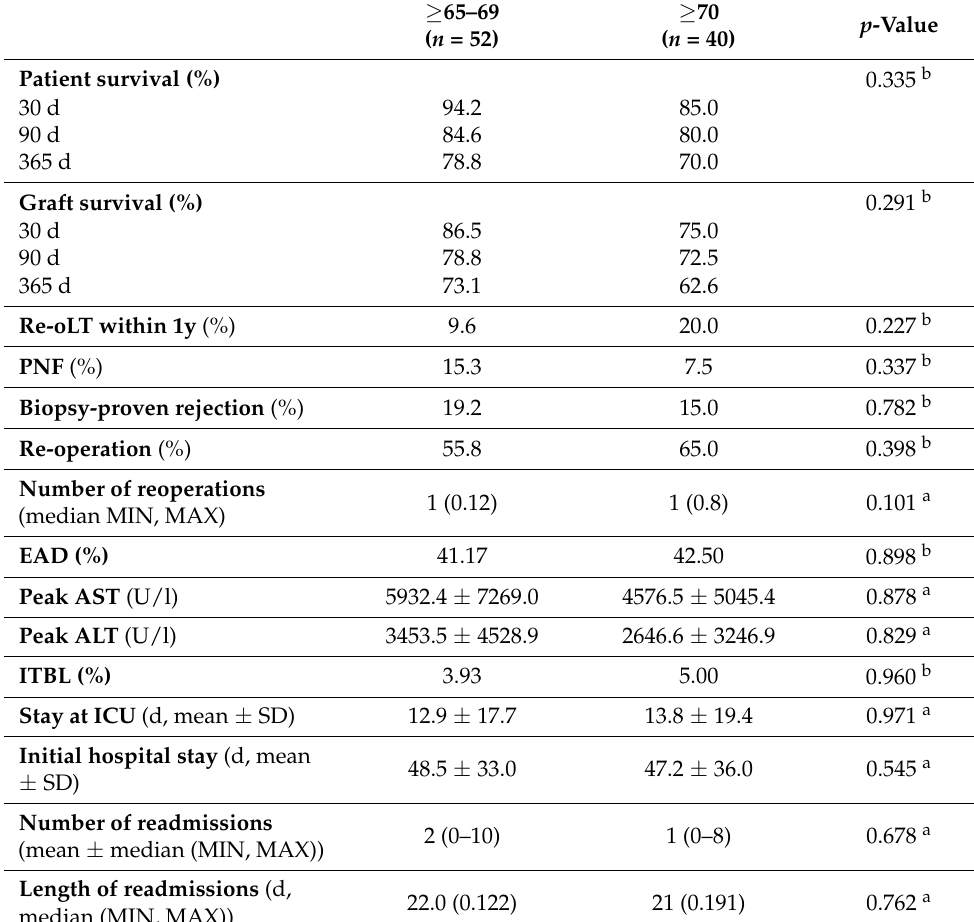
Table 4. Clinical